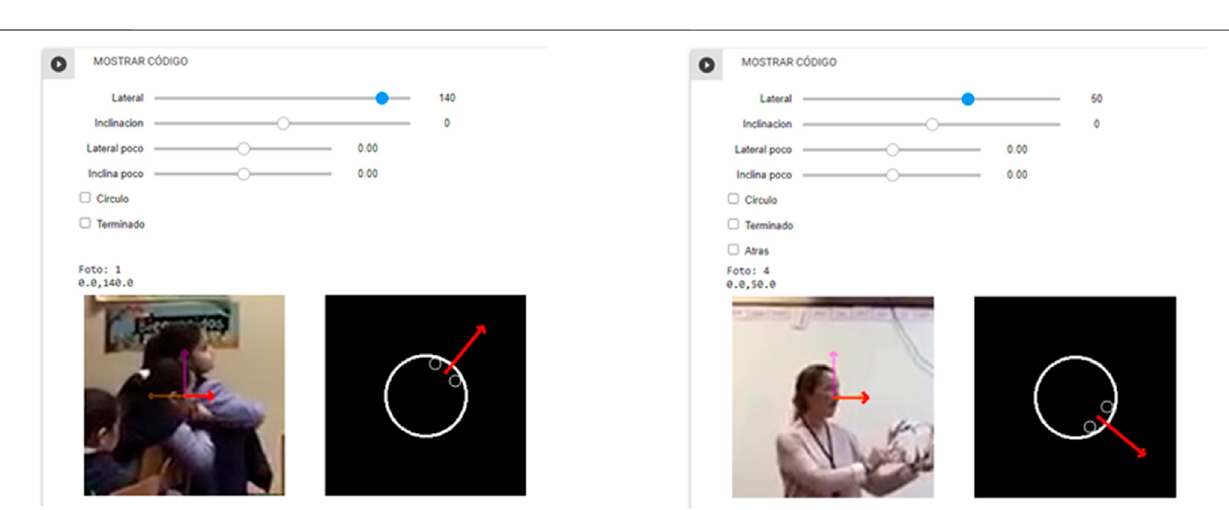
FIGURE 4 | Screenshot of the annotator interface. Left, screenshot showing a student. Right, screenshot showing the teacher. In each case, the annotator has to adjusttheredarrowmovingthefourbarsatthetop.Theannotatorhastwoviewoftheredarrow.Oneviewisinthevideoframe.Theotherviewisaniconicrepresentation of the subject and the red arrow as it would be seen from